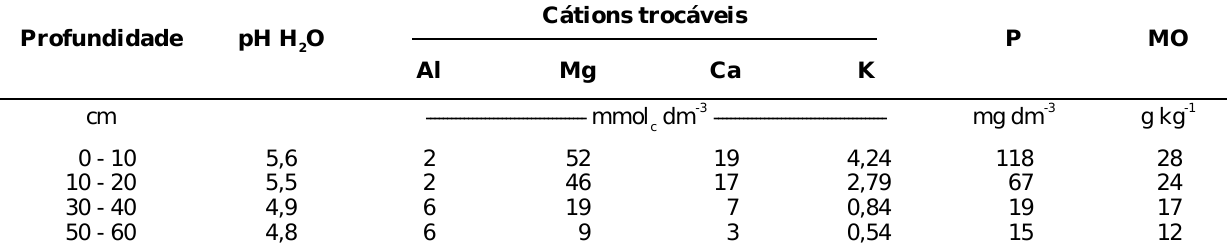
Quadro 1. Valores de pH em H 2 O, cátions trocáveis (Al, Ca, Mg, K), fósforo (P) e matéria orgânica (MO), determinados antes da instalação dos experimentos, para quatro profundidades do latossolo roxo de Dourados (MS)